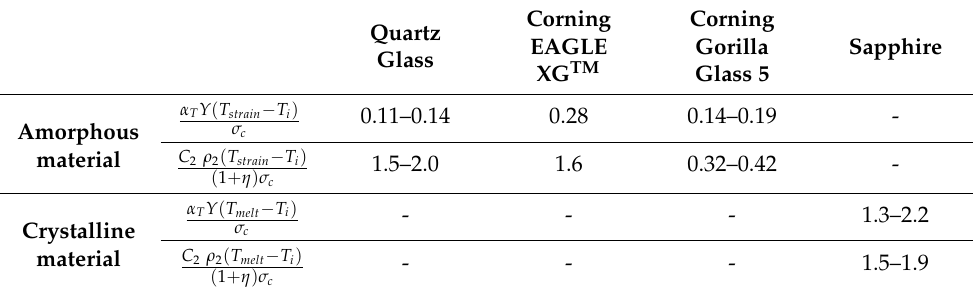
Table 4. Verification of criteria (86,88) for amorphous materials and (87,89) for crystalline materials, the simultaneous fulfilment of which is preferable for obtaining a separation with better smoothness. The parameters α T , Y , T strain , T melt , σ c , C 2 and ρ 2 , required for calculations, are taken from Table 2. Initial temperature is T i = 20 ◦ C, heat preservation factor is η = 0.76. Corning Corning Quartz Gorilla Sapphire EAGLE Glass Glass 5 XG TM α T Y ( T strain − T i ) 0.11–0.14 0.28 0.14–0.19 - σ c Amorphous material Crystalline